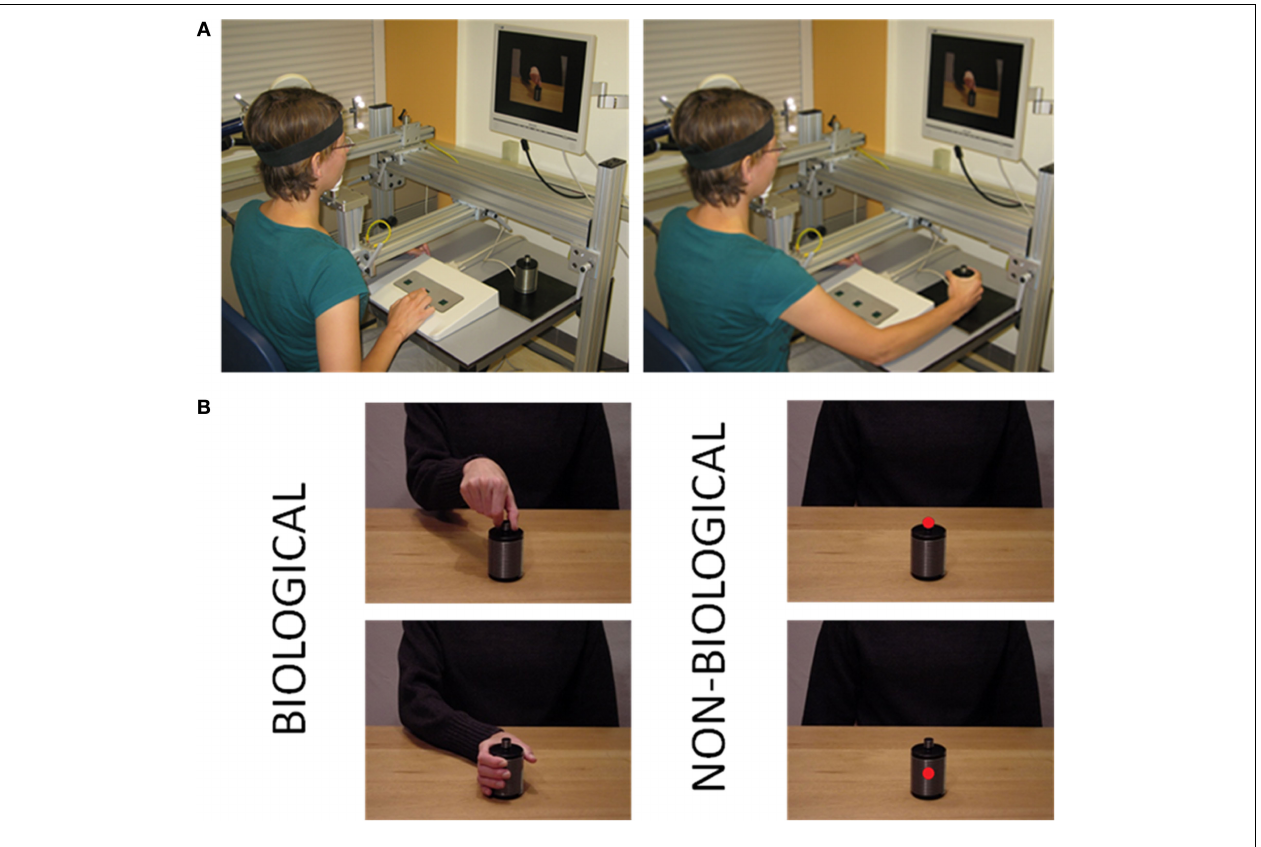
FIGURE 1 | (A) Experimental setup. Participants viewed stimuli presented on a screen directly in front of them. Responses were made using the right hand only. (B) Examples of stimuli used in the biological and non-biological conditions. Biological stimuli consisted of still photographs in which an actor grasped the manipulandum with their right hand using either a precision or a power